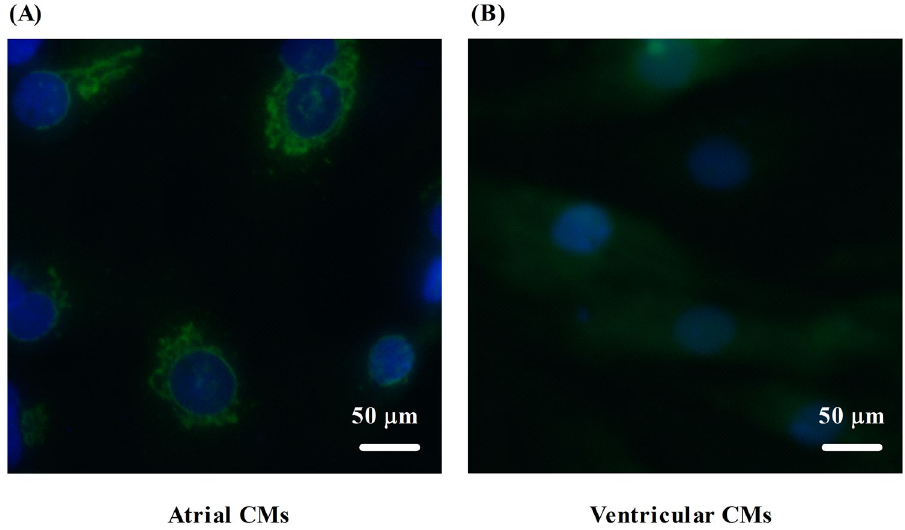
Figure 3. Ecrg4 is expressed in neonatal rat cardiomyocytes. Neonatal atrial and ventricular myocytes were prepared separately as described in materials and methods, which were seeded in a 6-well plate containing coverslips for overnight. Cells were fixed, permeabilized, and proceeded for immunofluorence using anti- Ecrg4 as primary antibody, goat anti-rabbit Alexa Fluor 488 as secondary antibody, and DAPI for nuclear staining. Representative images showing relative higher level of Ecrg4 (bright green) in perinuclear region and in endoplasmic reticulum in neonatal atrial myocytes ( A , left panel) compared to relative lower level of Ecrg4 (faint green) diffused in the cytoplasm of ventricular myocytes ( B , right panel). Scale bar = 50 µ m.